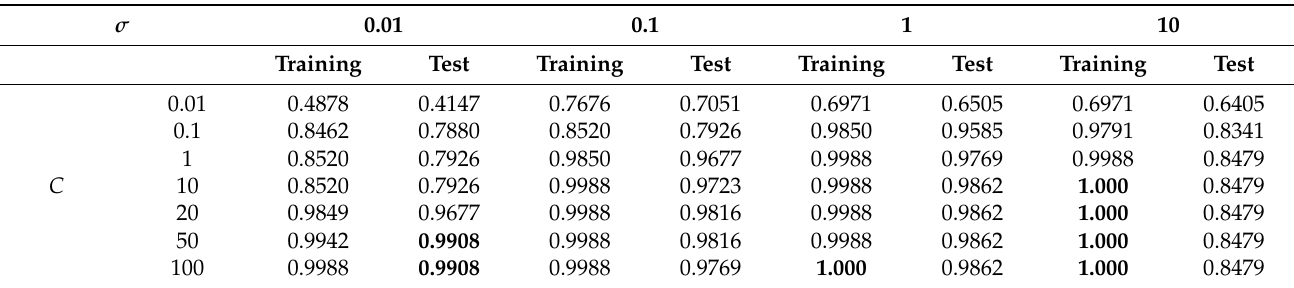
Table 5. SVM Hyperparameter Optimization.